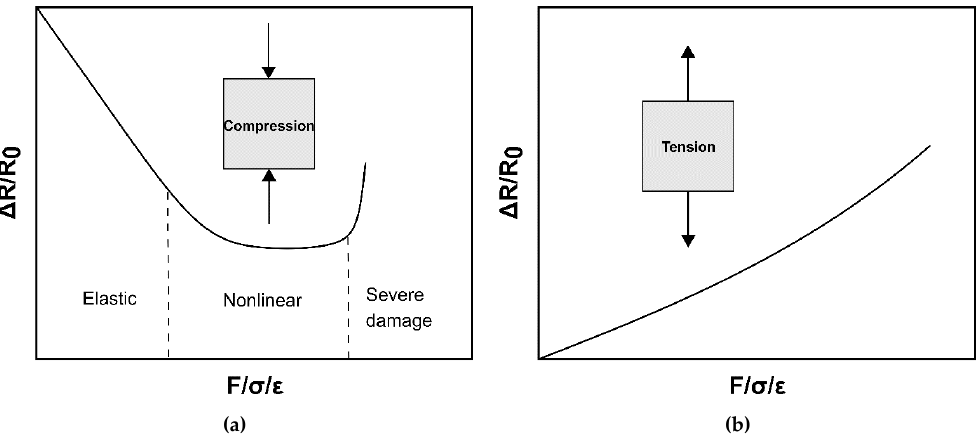
Figure 4. Diagram of typical response of AAM under ( a ) compression ( b ) tension; the x-axis represents the force, stress, or strain applied to the binder. The y-axis displays the fractional change in resistance (or impedance) in relation to the external factors applied.